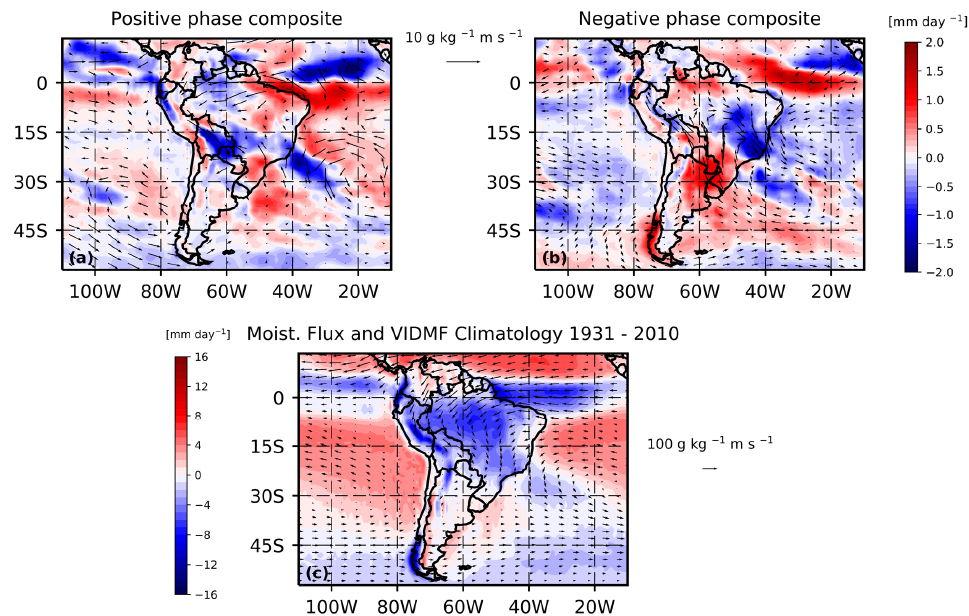
Figure 9. ( a ) DJF Anomalies of 850 hPa moisture flux (arrows) and VIDMF (shading) corresponding to the composite of the 10 years with the maximum magnitude of PC4; ( b ) As in ( a ) but for the 10 years with the minimum magnitude of PC4; ( c ) DJF Climatology of 850 hPa moisture flux (arrows) and VIDMF (shading) for the 1931–2010 period. Data from ECMWF ERA-20C reanalysis. To detect anomalies in the SAMS related to PC4, anomalies of the composites of 850 hPa wind for the DJF season were calculated for the 10 years with the maximum and min- imum magnitudes of PC4 (Figure 9a,b). DJF is analyzed because this is the season when the SAMS is most active. For the positive phase (Figure 9a), an anomalously strong SAMS is recognized by stronger than average equatorial Atlantic trade winds and stronger than average SALLJ. During the monsoon season, the SALLJ transports moisture to the central Amazon, and to Bolivia and Paraguay. The positive phase of PC4 is also associated with a stronger than average subtropical anticyclone over the South Atlantic. This suggests that the strength of the South Atlantic subtropical anticyclone is correlated to the strength of the SAMS. The stronger South Atlantic anticyclonic might be linked to the negative precipitation anomaly over north eastern Brazil (Figure 2d), through suppressed moisture flux convergence. The opposite is observed for anomalies related to the negative phase of PC4, i.e., weaker Atlantic trade winds and SALLJ. Suppressed moisture transport is observed es- pecially in the equatorial Atlantic, northern Brazil, and in the area over the La Plata river basin, where the SALLJ brings moisture. In addition, the anticyclonic 850 hPa moisture flux anomaly in the south Atlantic is shifted northward, while a cyclonic 850 hPa moisture flux anomaly is observed just to the south of this anticyclonic anomaly. This spatial pat- tern explains the precipitation anomalies related to the negative mode of PC4.